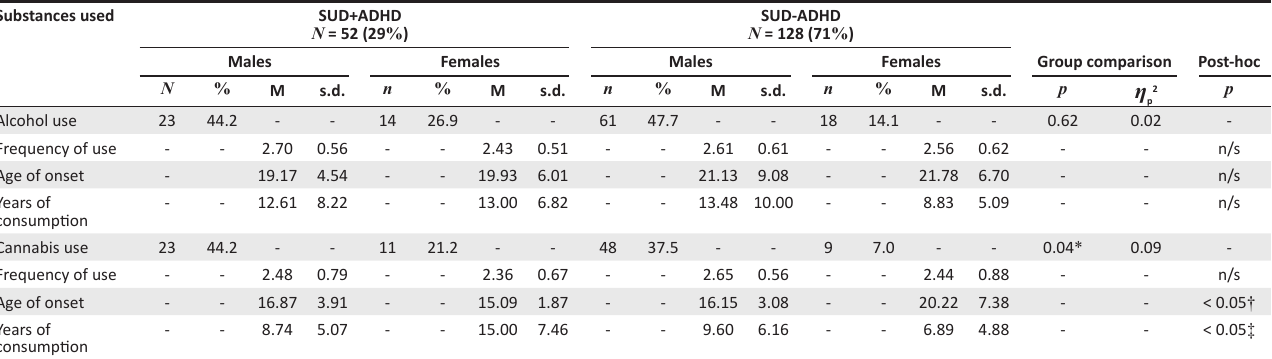
TABLE 2: Alcohol and Cannabis use. Substances